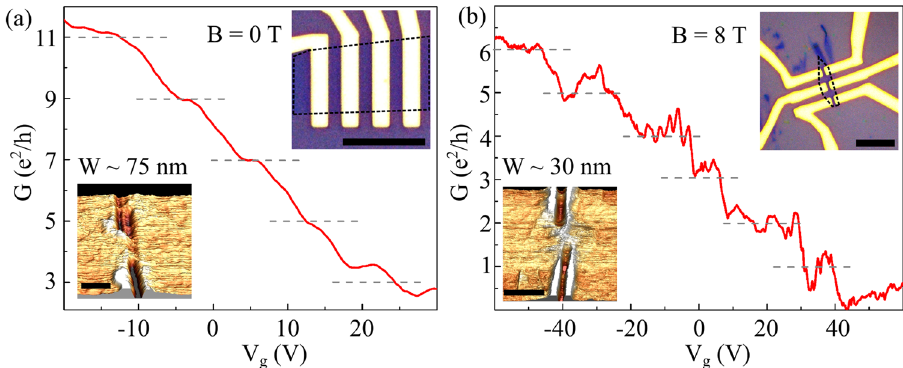
Fig. 3 Conductance measurements (1.5 K) of graphene QPCs patterned by AFM cleavage lithography with cuts running along zigzag directions. (Upper insets: optical images of the devices. Lower insets: 3D topographic AFM image of the nanoconstrictions, scale bars are 100 nm.) a Two-probe conductance curve in zero magnetic fi eld, for a ~75 nm wide constriction revealing conductance plateaus at integer n × e 2 / h values separated by 2 e 2 / h steps. b Two-probe conductance curve measured through a ~30 nm wide graphene constriction in 8 T magnetic fi eld displaying quantization steps with e 2 / h